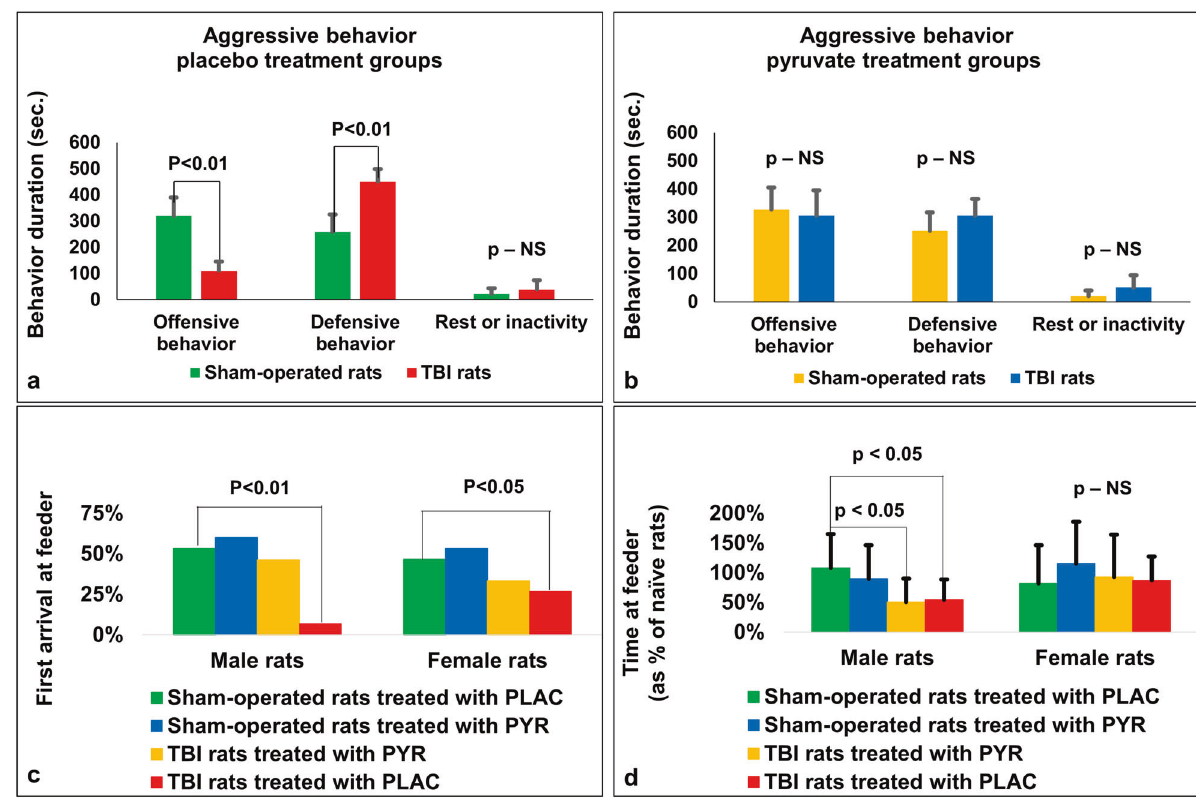
Fig. 4 Results for the resident-intruder paradigm and assessment of dominant-submissive behavior. For the placebo group ( a ), TBI was shown to signi fi cantly decrease offensive behaviors and increase defensive behavior, with no effect on passive behavior. In rats treated with pyruvate ( b ), there was no signi fi cant change in offensive, defensive, or passive behaviors. There was a signi fi cant difference for female rats in the number of rats who came fi rst to the feeder, for post-TBI rats given placebo ( c ). There was signi fi cantly less time spent at the feeder for male rats on the dominant-submissive task for post-TBI rats treated with pyruvate and post-TBI rats given placebo compared to sham- operated rats treated with placebo ( d ). There was no difference between groups in time spent at the feeder for female rats on the dominant- submissive task. NS not signi fi cant, PLAC Placebo, PYR Pyruvate, TBI Traumatic brain